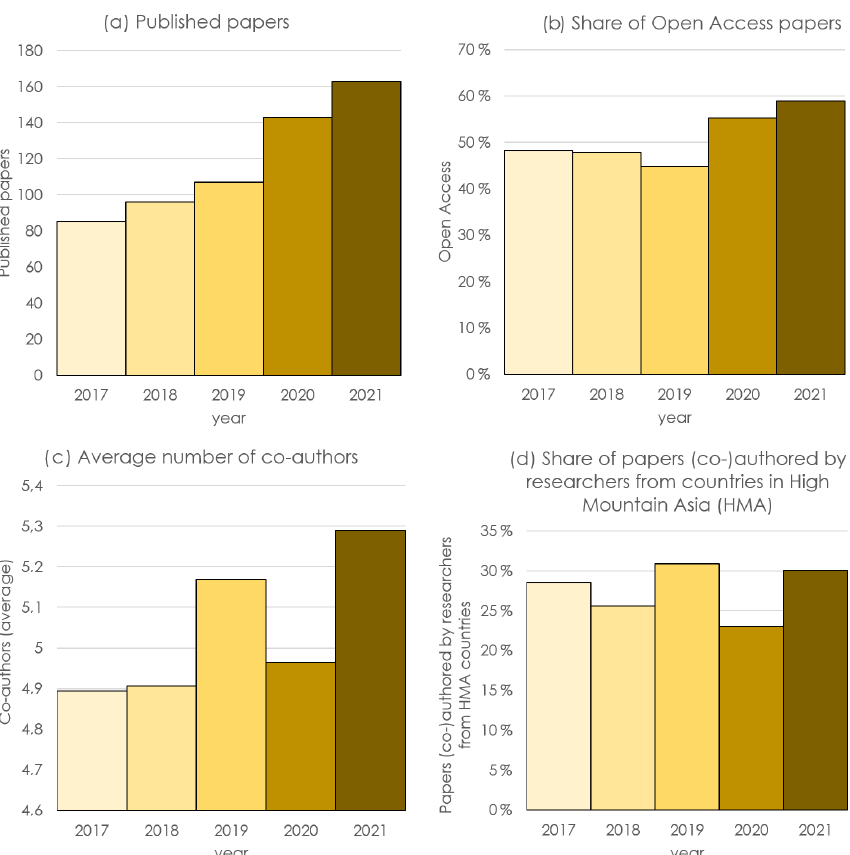
Figure 1. Basic characteristics of published GLOF papers covered by WOS and Scopus databases. (a) Published GLOF papers in each year; (b) share of open-access papers; (c) average number of co-authors (Sect. 3.4); (d) share of papers (co-)authored by authors from countries in High Mountain Asia (see Sect. 3.4 for more